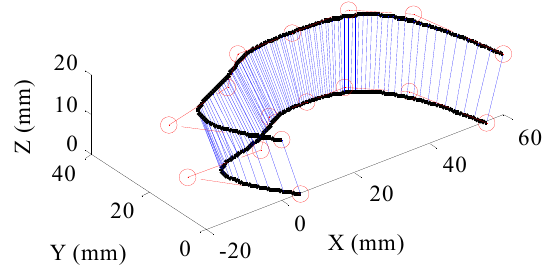
Figure 5. The open − pocket tool path.